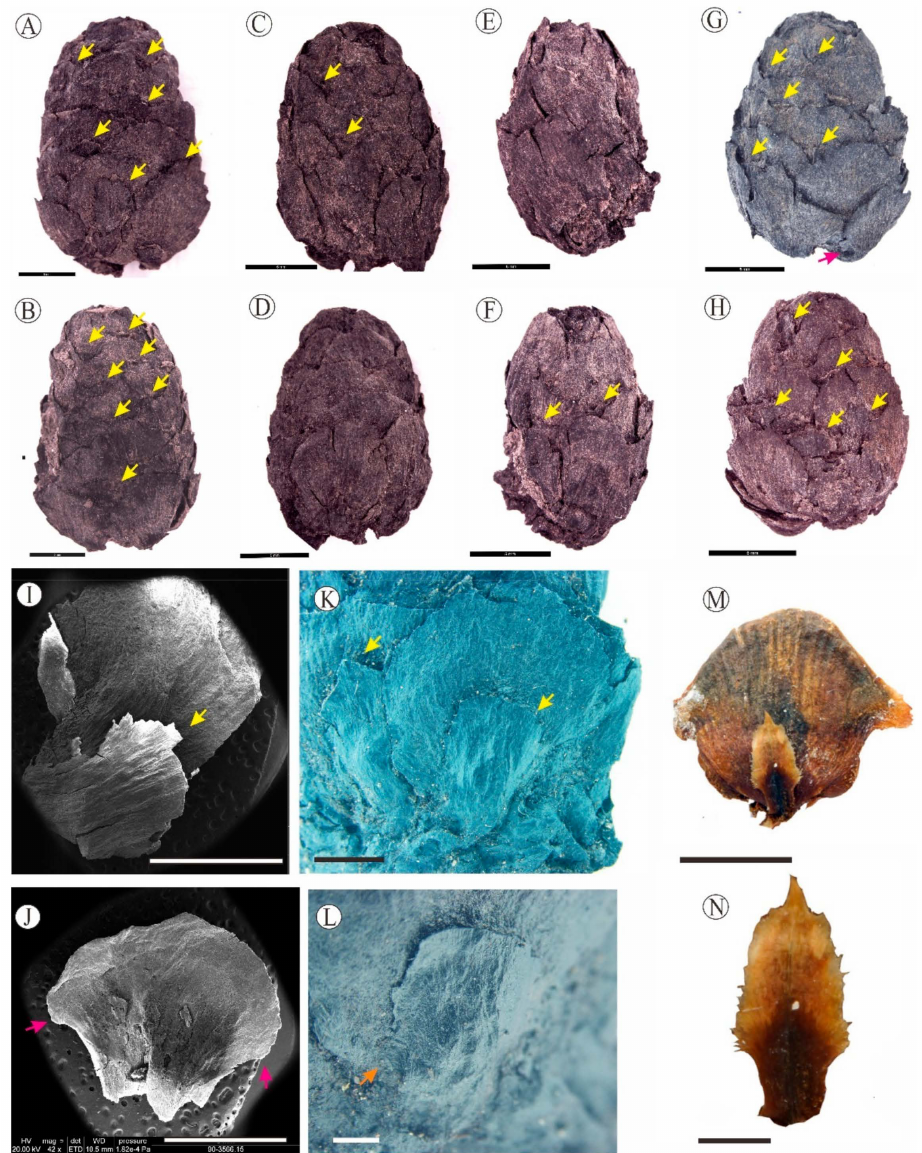
Figure 2. ( A – L ) Nothotsuga mulaensis from the Mula Basin, Litang County, Sichuan Province and ( M , N ) Seed scale and bract of N. longibracteata , which are from Xu et al. [31]. ( A – H ) Seed cones as seen from both sides, showing the exserted bracts with yellow arrows and auriculate scales with pink arrows. ( I ) Seed scale with bract of N. mulaensis under the scanning electron microscope, showing the bract with yellow arrows. ( J ) Scale of N. mulaensis under the scanning electron microscope, showing the auriculate bases with pink arrows. ( K ) Seed scale with bract in abaxial view, showing acute or acuminate bract with yellow arrows. ( L ) Bract of N. mulaensis , showing ligulate-spathulate in shape. ( M ) Seed scale with bract in abaxial view of N. longibracteata , showing auriculate scale. ( N ) Bract of N. longibracteata , showing dentate margin and acute apex. ( A – H ) Scale bar = 5 mm; ( I , J , N ) Scale bar = 3 mm; ( K ) Scale bar = 2 mm; ( L ) Scale bar = 1 mm; ( M ) Scale bar = 8